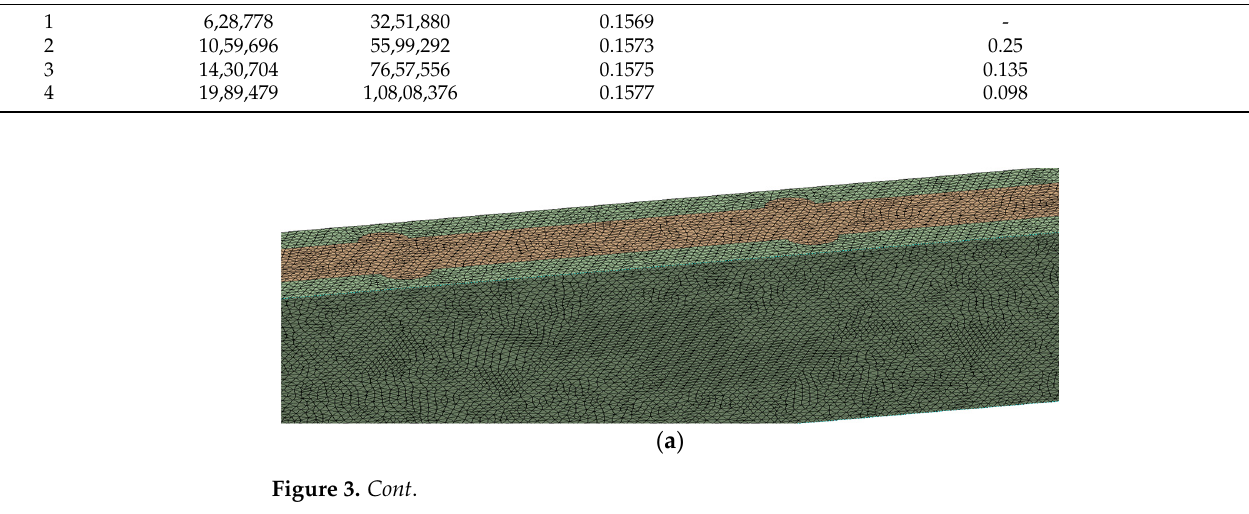
Table 2. Microchannel heat sinks (MCHS) (silicon): the thermophysical properties.